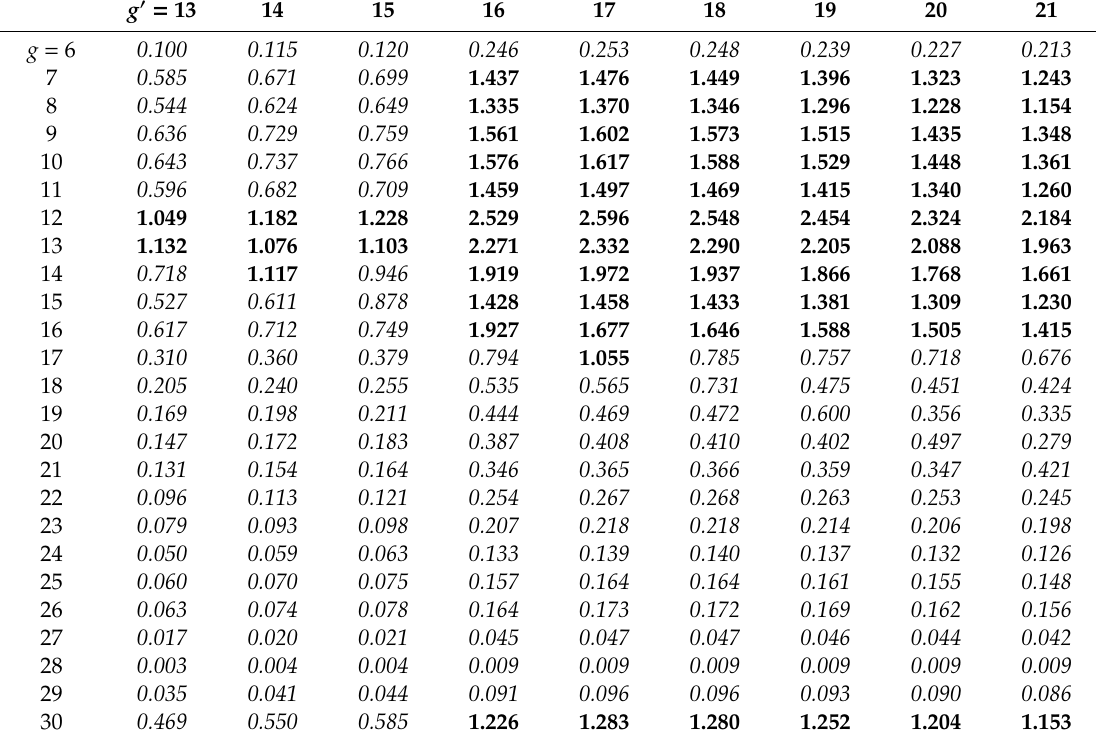
(cid:16) (cid:17) (cid:48) σ g , σ g , g , g (cid:48) = 1, ... ,30 having values greater than 1.0. t , i = 1 t , k = 6